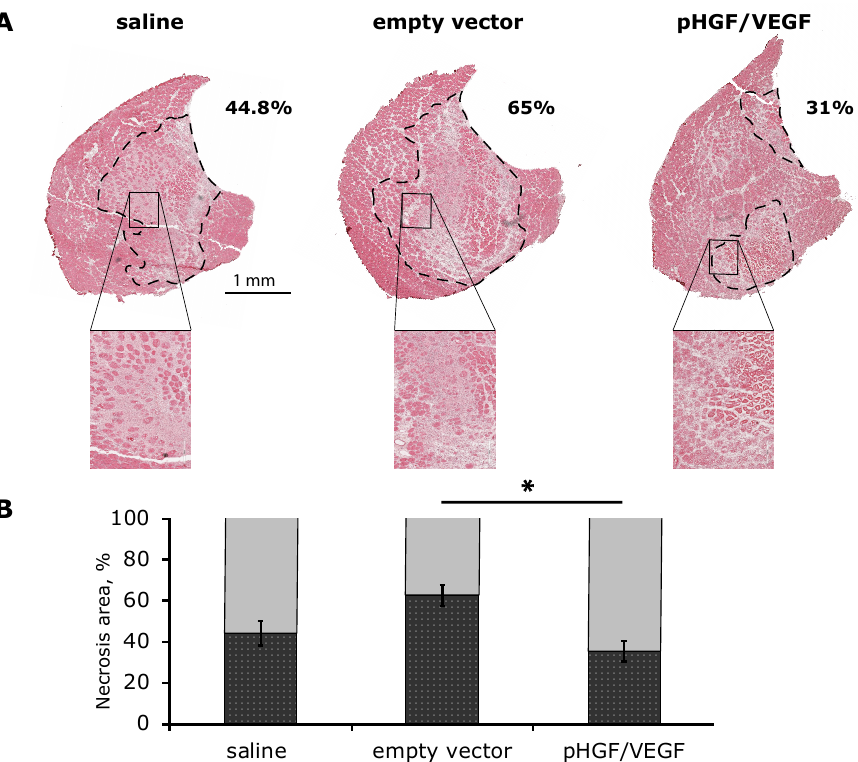
Figure 8. Histological analysis of necrosis in ischemic skeletal muscle at Day 14 after ischemia. ( A ) Whole-section images of hematoxylin / eosin-stained m. tibialis anterior. Necrotic tissue region of interest is marked by a dashed line; high-magnification boxes demonstrate signs of muscle necrosis including lack of nuclei, fiber loss of morphology and disruption and edema accompanied by infiltration of immune cells. ( B ) Graphical presentation of necrotic tissue span. Data are presented as mean ± SEM, * p < 0.05 for pHGF / VEGF vs. empty vector